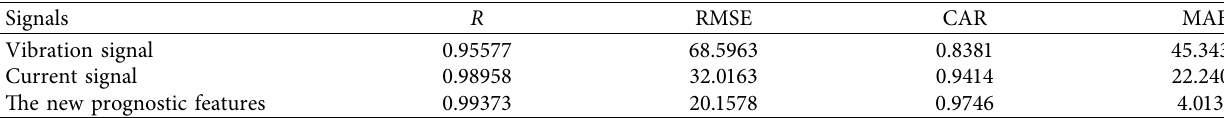
Figure 13: BAS-BP model prediction results of current signal. (a) Training set. (b) Test set. Table 6: Te evaluation results of the test